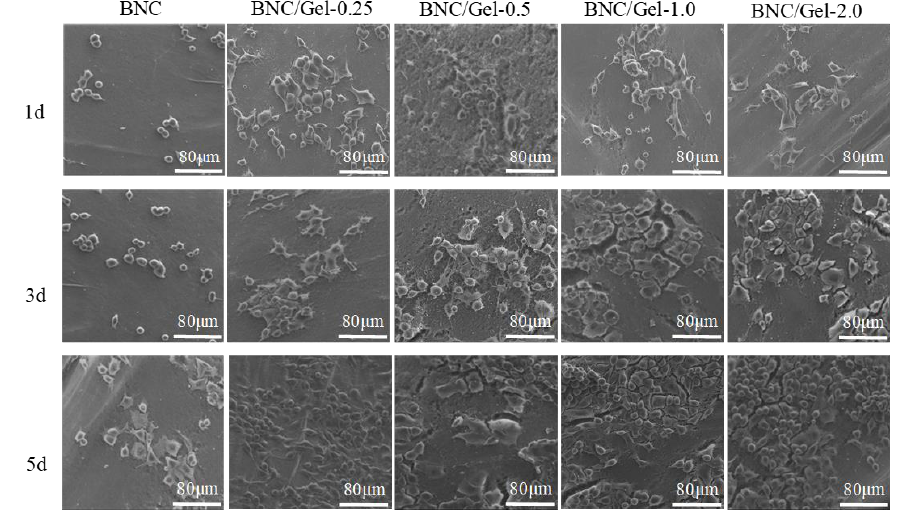
Figure 7. SEM images of HUVECs grown on the surfaces of samples. (2) The growth of HSMCs